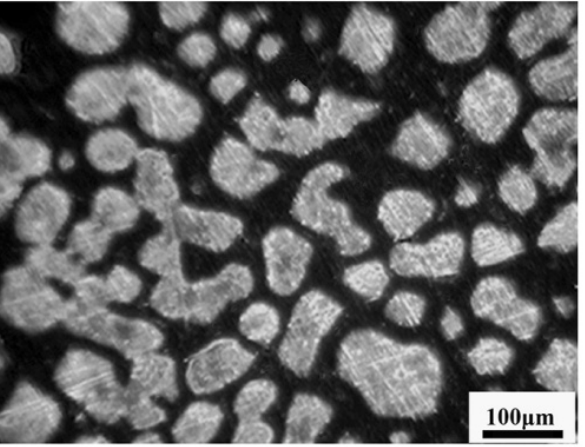
Figure 5. The final solidified microstructure of the Ce ‐ HMASS sample under the cooling rate of 100 °C /min.